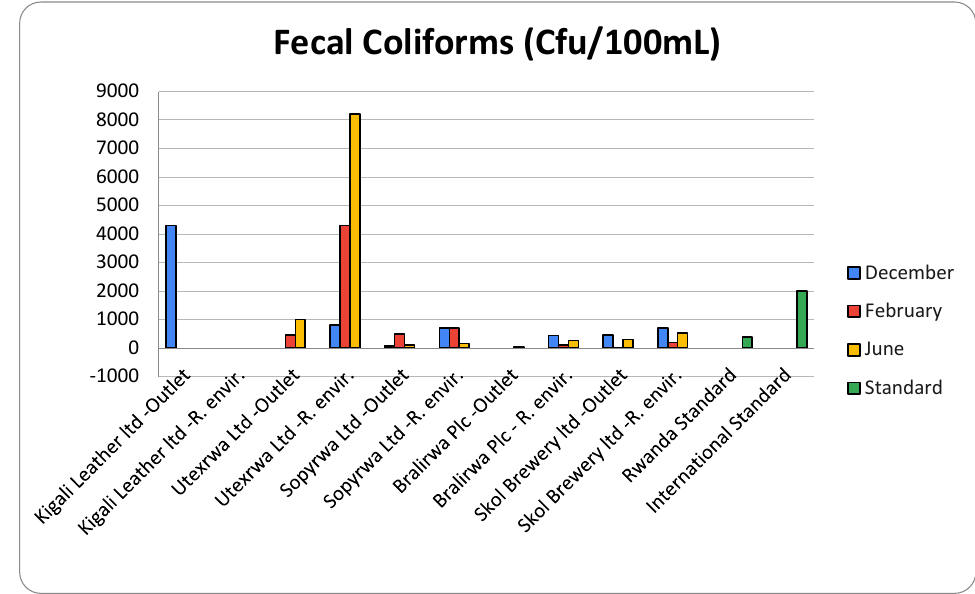
Figure 10. Fecal Coliforms discharge levels per site.